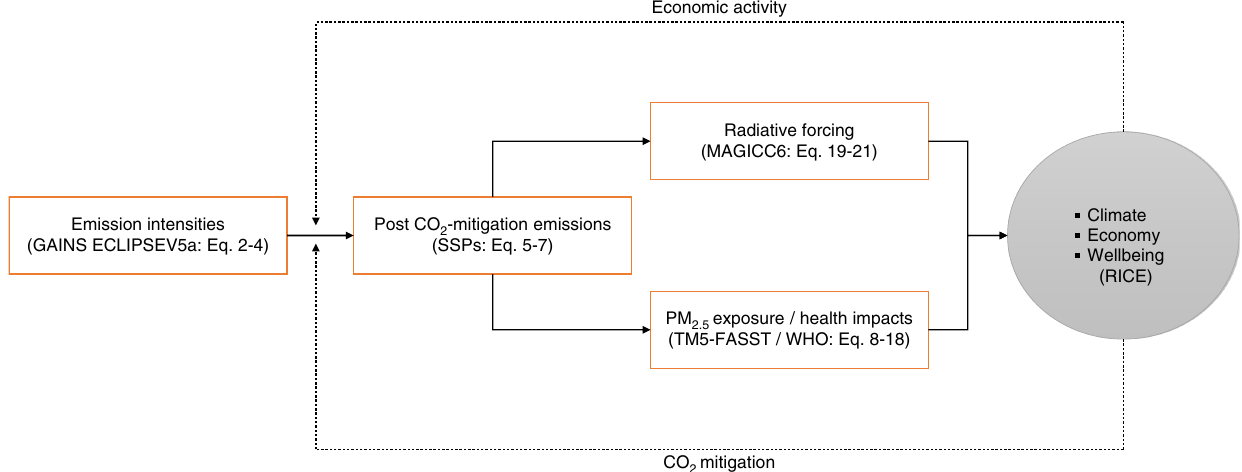
Fig. 7 Diagram of the AIR module. Flow chart illustrating how the AIR module (rectangles) links with the RICE model (gray circle) to estimate emissions of air pollutants and their impacts. The model/method underlying each step in AIR is shown within parentheses, along with the relevant